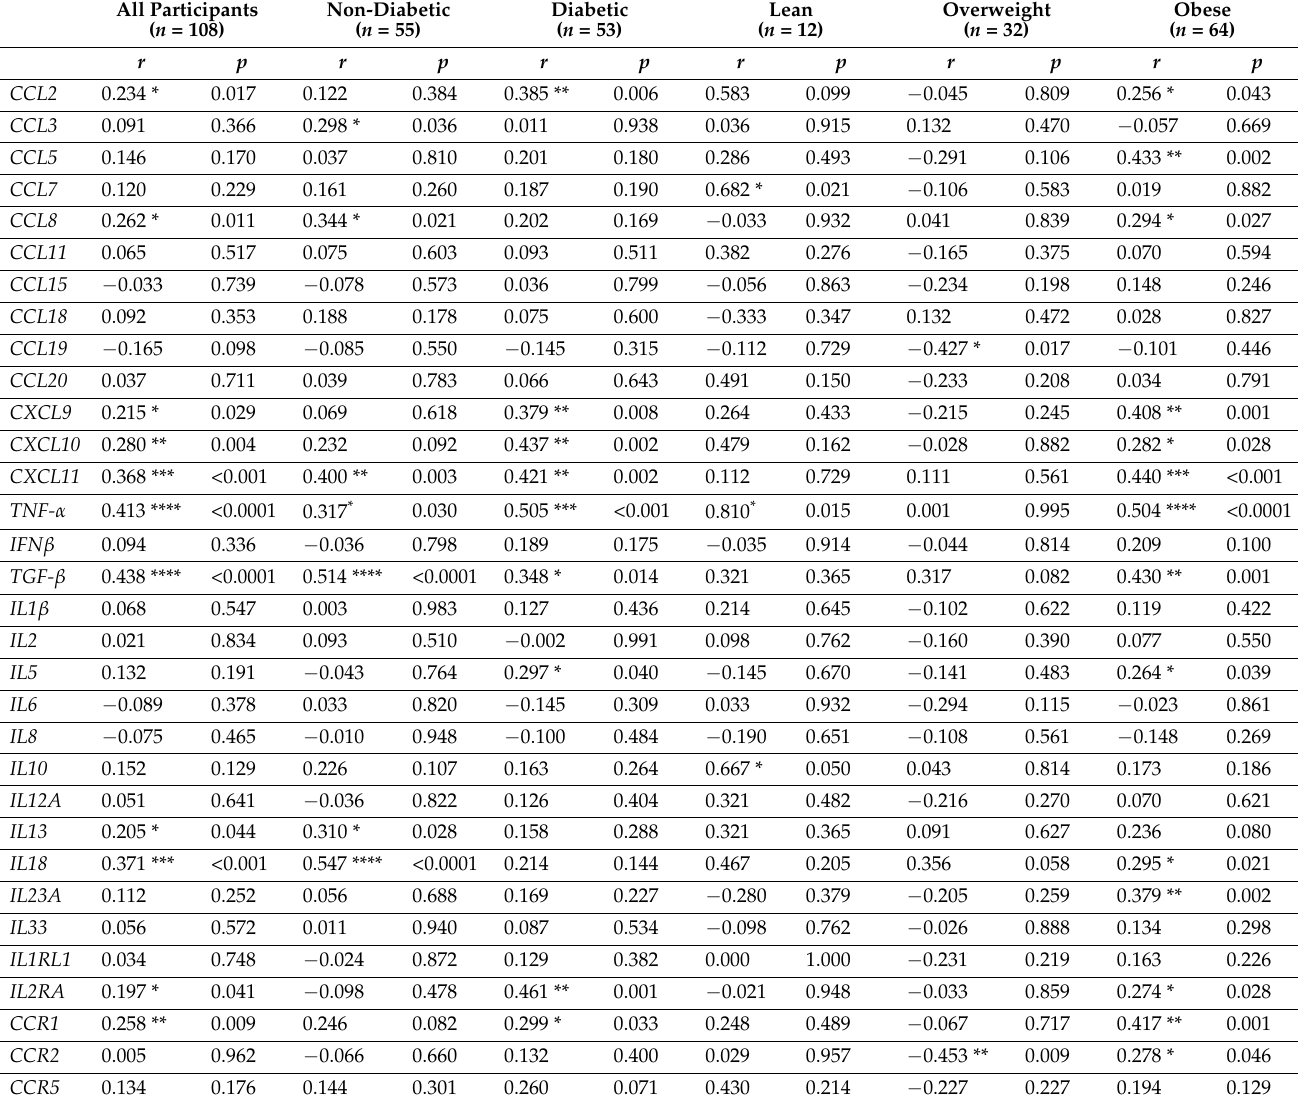
Table 4. Correlation of the SRA1 expression levels with inflammatory markers in adipose